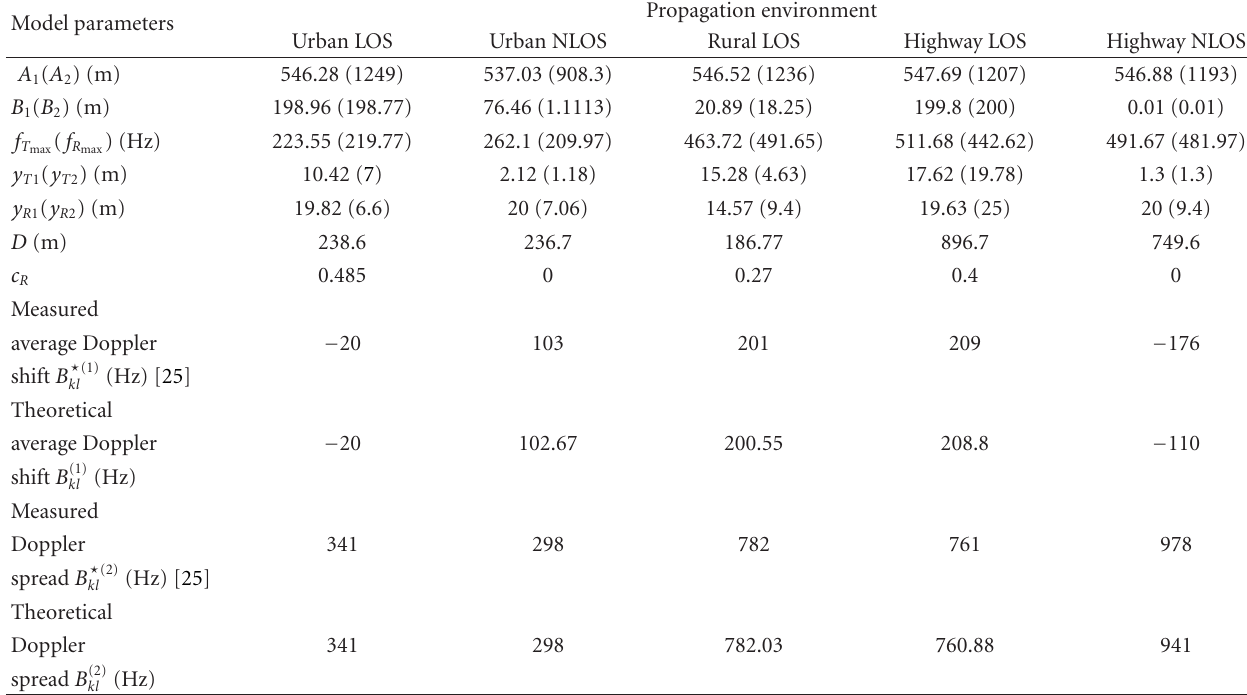
Table 1: Measurement-based parameters of the geometrical street scattering model and the resulting average Doppler shift and the Doppler